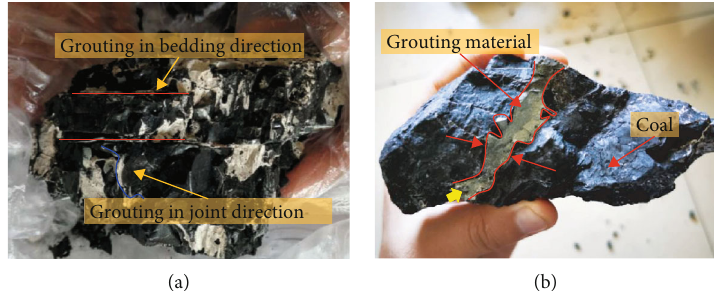
Figure 11: Support design of grouting reinforcement.